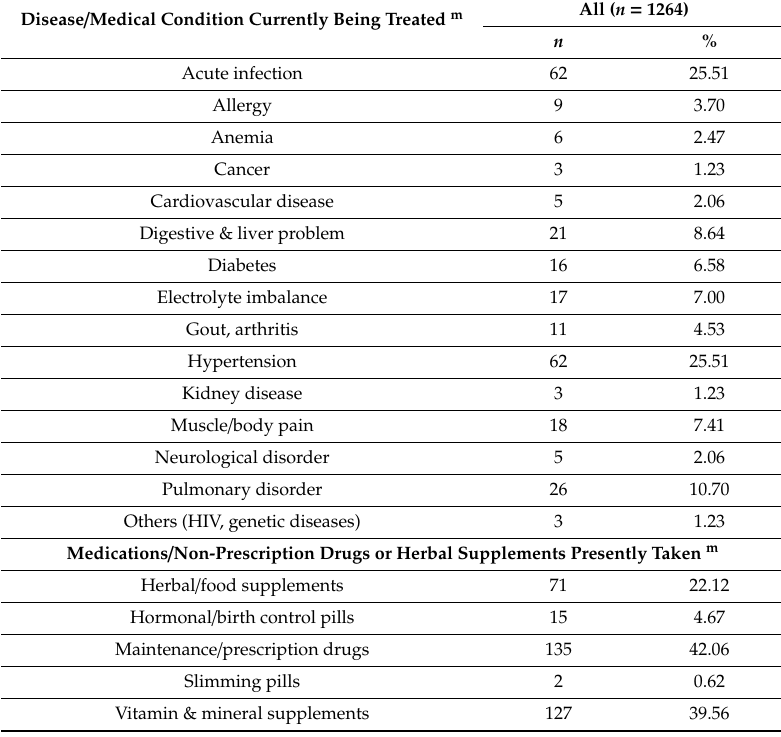
Table 5. Percentage distribution of the respondents with medical conditions, and medications